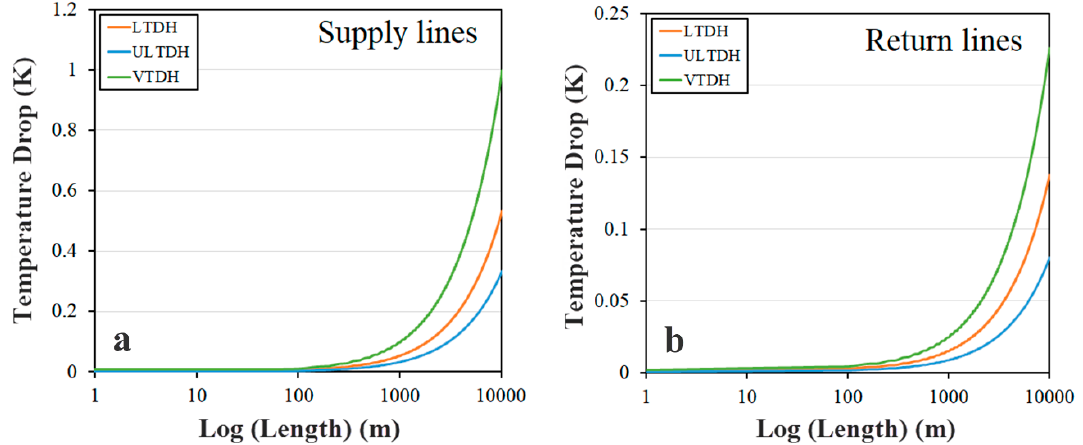
Figure 6. The temperature profile of the supply and return lines for different cases. ( a ) supply lines; ( b ) return lines.